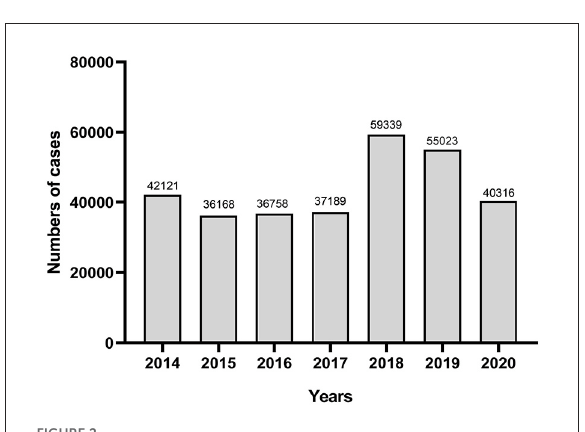
FIGURE2 Distribution of cases by